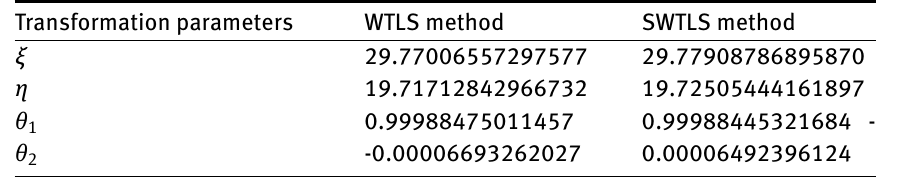
Table 4: Transformation parameters derived by WTLS and SWTLS and reference value.